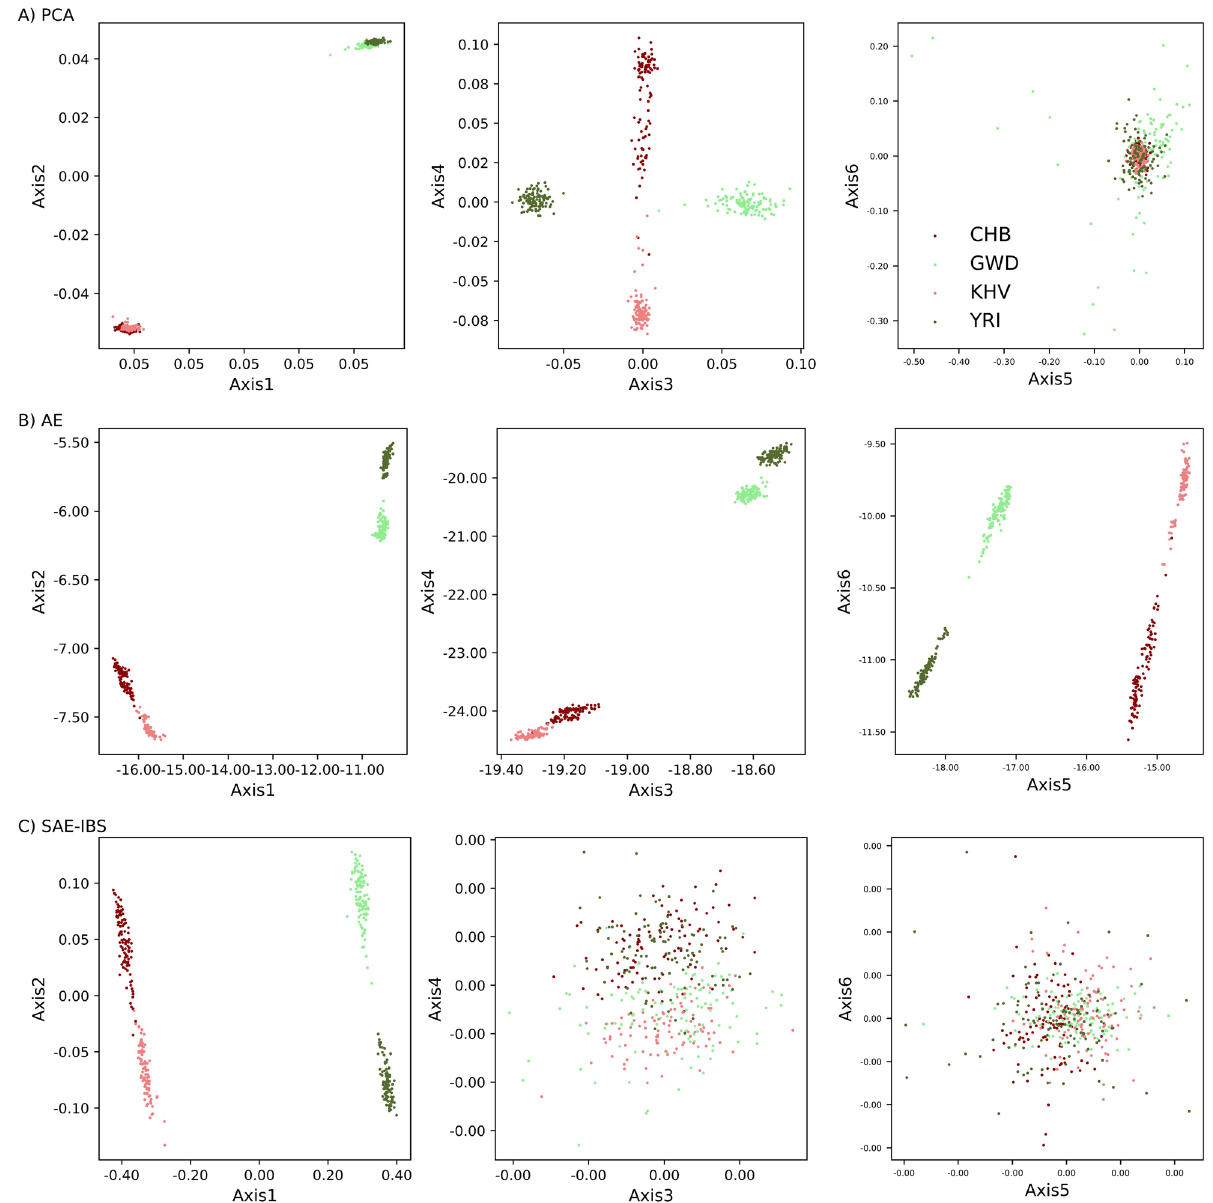
Figure 5. Comparison of population inference at super-population and sub-population level. The first six ancestry components for ( A ) PCA, ( B ) AE and ( C ) SAE-IBS using four sub-populations from the 1KGP dataset. The color of a point represents the ancestry of an individual, dark red for Han Chinese in Beijing, China (CHB), light red for Kinh in Ho Chi Minh City, Vietnam (KHV), light green for Gambian in Western Division, The Gambia (GWD), and dark green for Yoruba in Ibadan, Nigeria